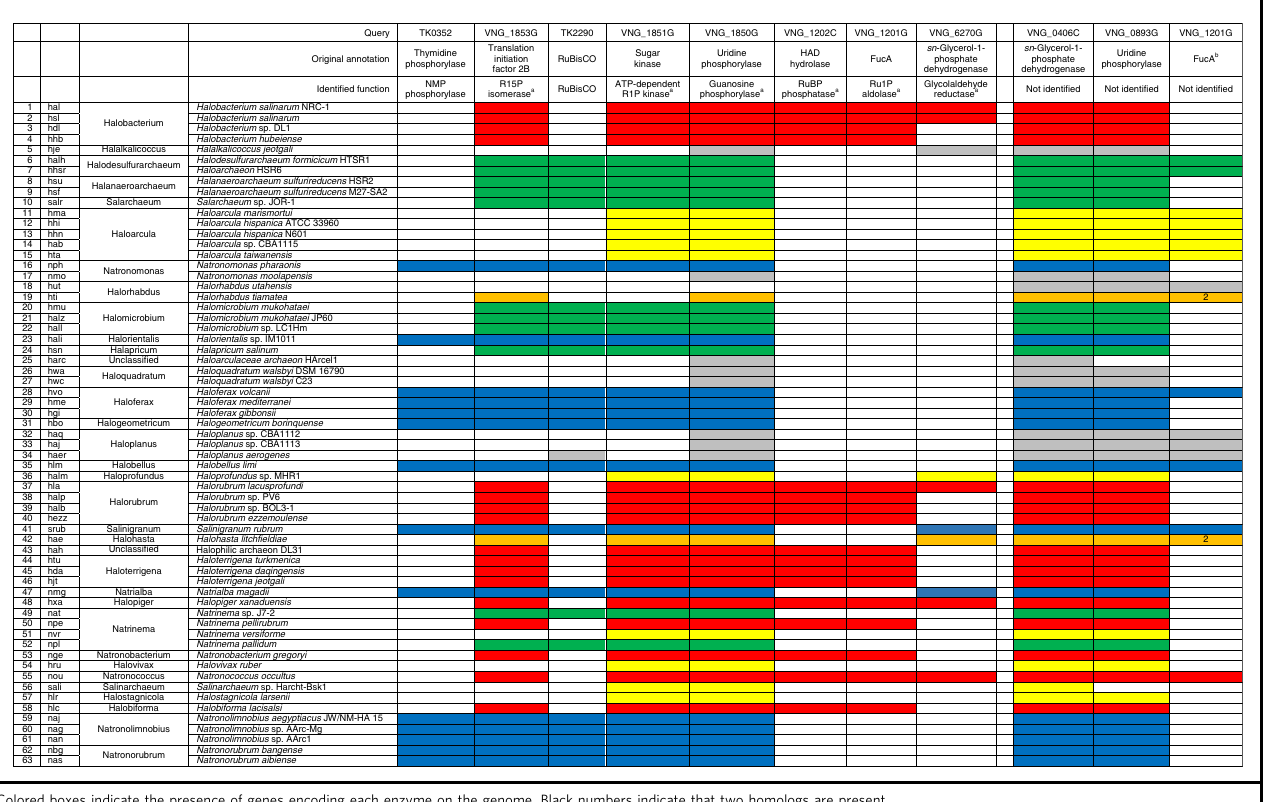
(Supplementary Fig. 9a) and 2.1 ± 0.1 μ mol min − 1 mg − 1 and 4.8 ± 0.8 mM toward phosphate (Supplementary Fig. 9b), respec-